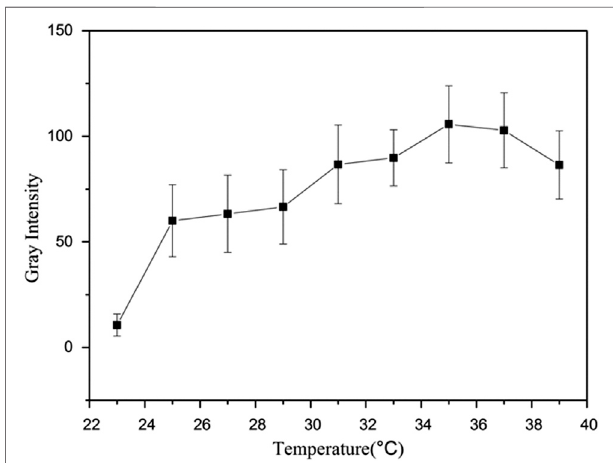
Figure 6 | Representative in vitro ultrasonic images. Quantitative gray- scale for the ultrasonic intensity of Lf – PLLA nanobubbles from 23 to 39 ° C.